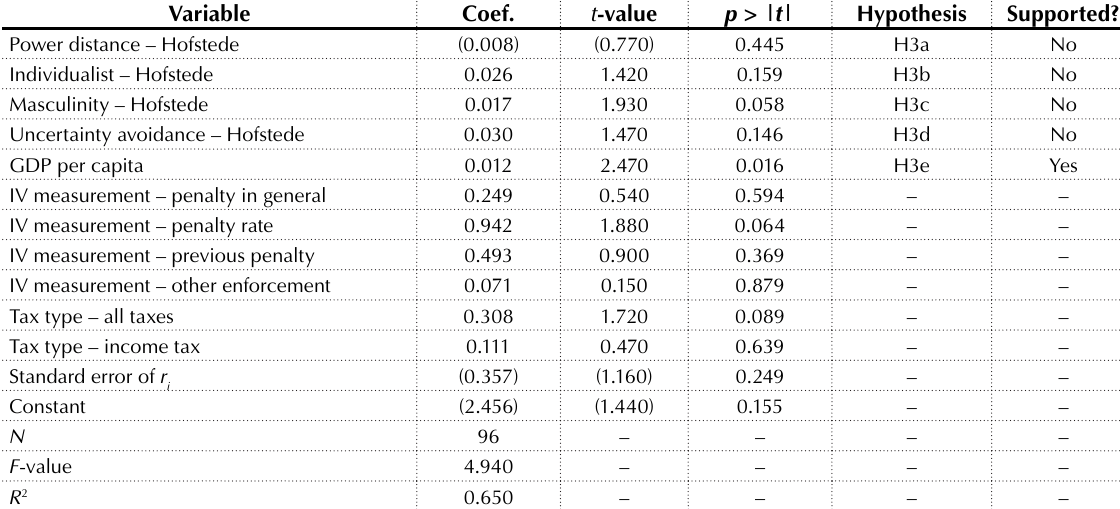
Table 10. Moderator variables –